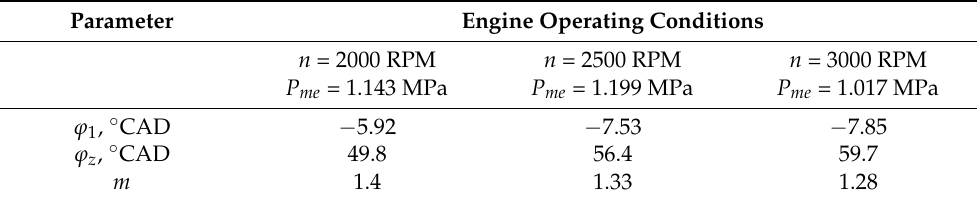
Table 3. Wiebe heat release parameters calculated using AVL Boost Burn.